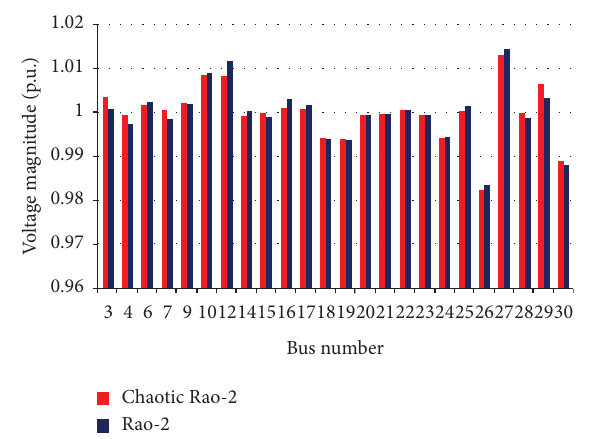
Figure 7: Comparison of system voltage profle obtained for case 4 using the chaotic Rao-2 and Rao-2